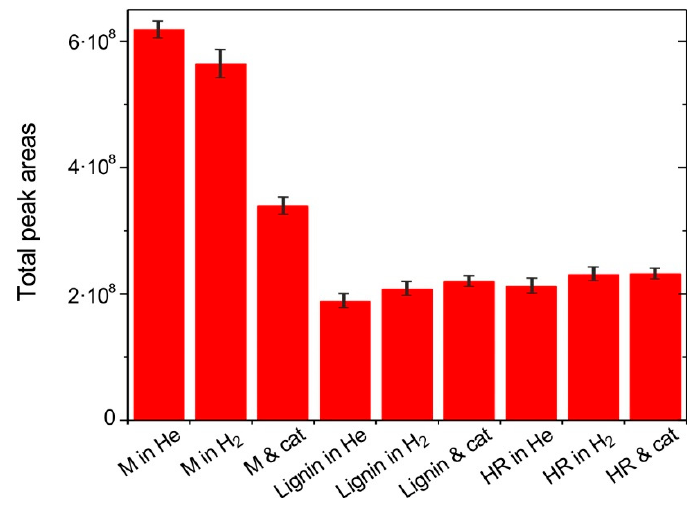
Figure 11. Effects of H 2 and catalyst on different feedstock.